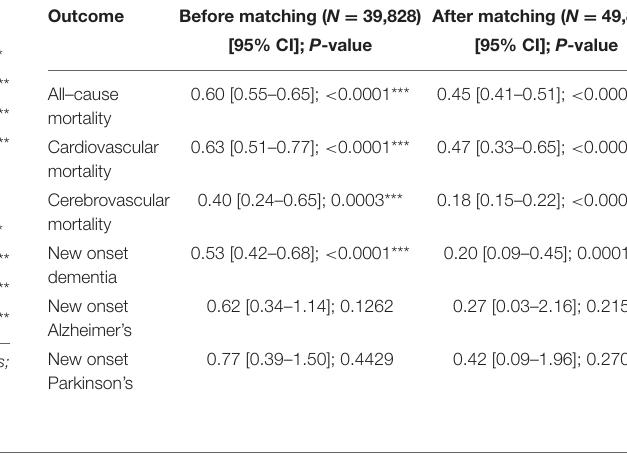
TABLE 5 | Subgroup analysis: Treatment effects of SGLT2I vs. DPP4I for incident adverse cognitive dysfunction events, and mortality outcomes in patients with both type − 2 diabetes mellitus and cardiovascular diseases before and after propensity score matching (1:2). Outcome Before matching ( N = 39,828) After matching ( N = 49,830)